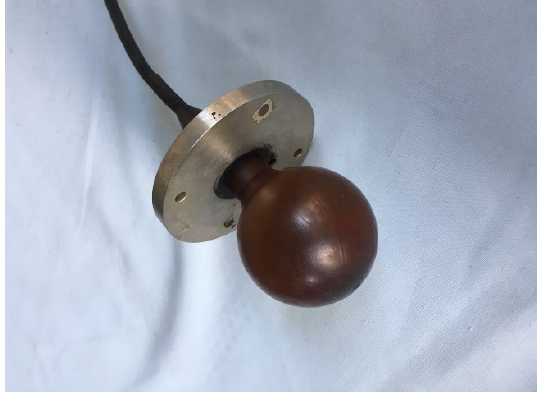
Figure 7. Block diagram of the experiments.